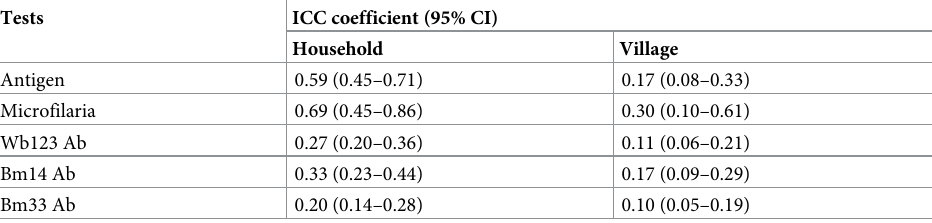
Table 1. Summary table of intra-cluster correlation (ICC) coefficients (adjusted for age and sex) for lymphatic fil- ariasis infection markers by village and household levels, American Samoa